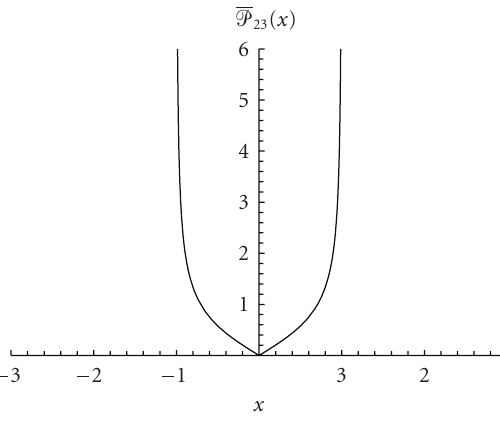
Figure 7.6. The function (cid:2) 23 ( b = 1, κ = 1, b 0 =